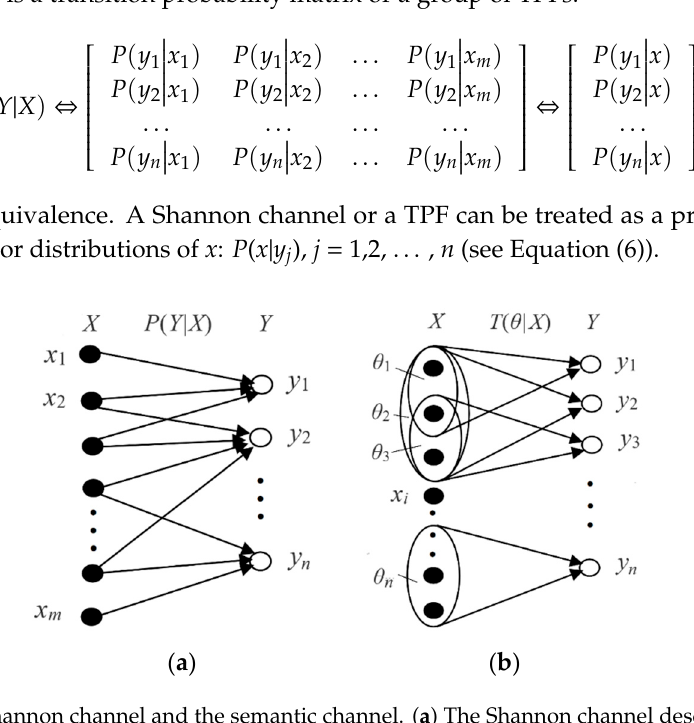
Figure 2. The Shannon channel and the semantic channel. ( a ) The Shannon channel described by the P probability frame; ( b ) the semantic channel described by the P–T probability frame. A membership function ascertains the semantic meaning of y j . A fuzzy set θ j may be overlapped or included by another.